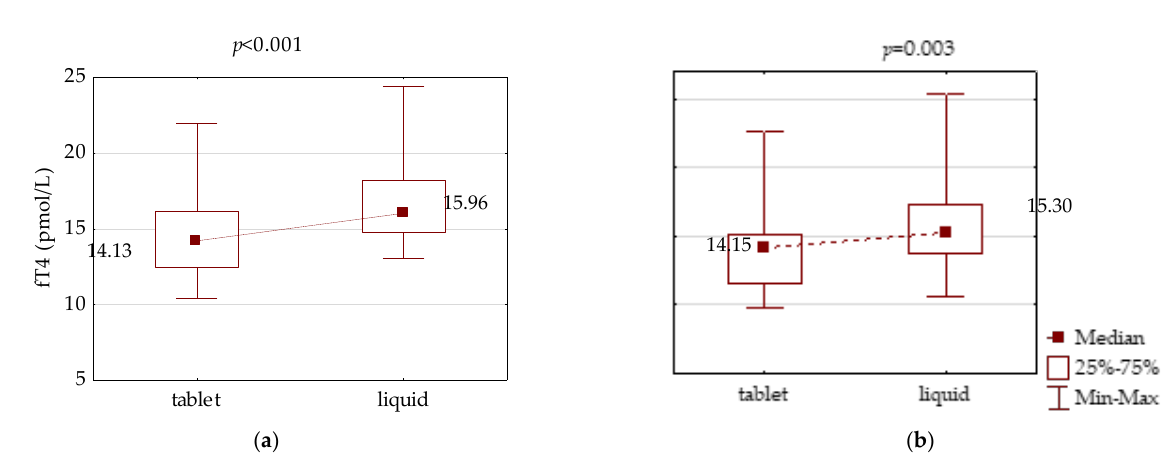
Figure 1. Comparison of TSH serum concentration between LT4 therapy in tablet and liquid form in an equivalent dose in: ( a ) primary hypothyroidism and ( b ) central hypothyroidism.